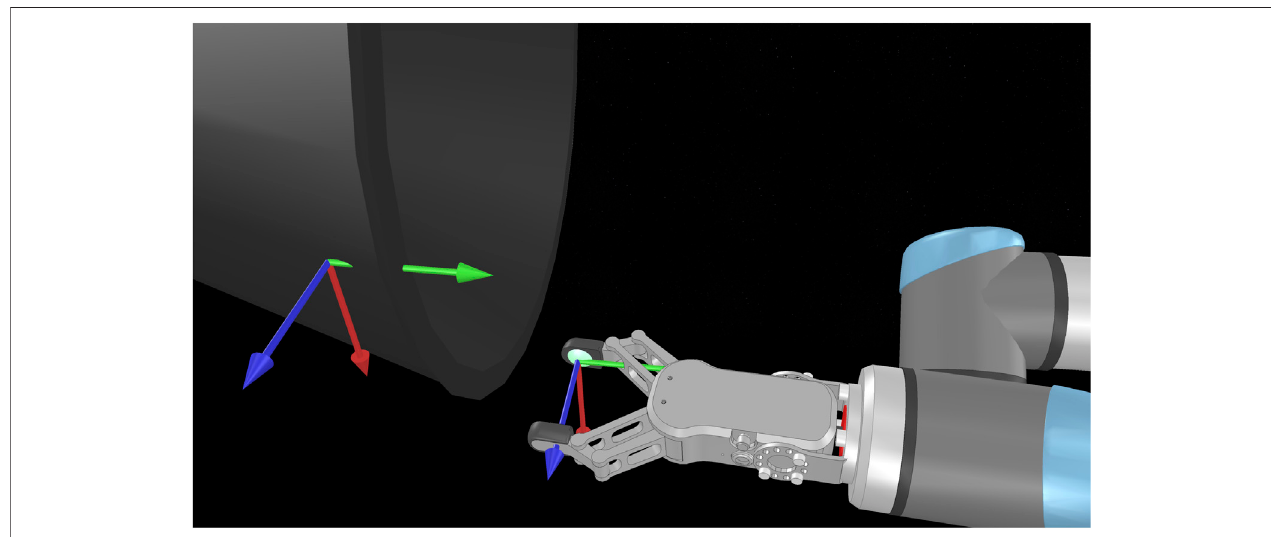
FIGURE7| Thegraspingandright fi ngertipcoordinateframes S B 2 and S A 2 ( leftandright framesonthepicture).InV-REP,wecandirectlymeasurethedistanceof the fi ngertip frames w.r.t the grasp frame, and the rotation over the axis perpendicular to the surface. The distance and rotation constitute the measured slippages.